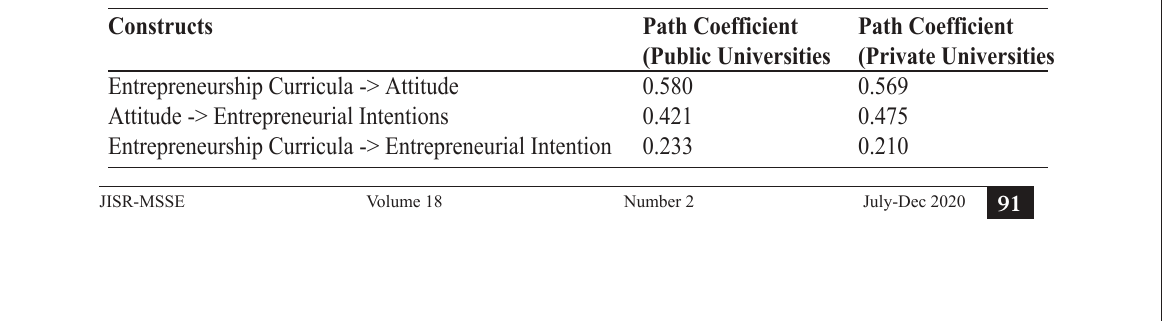
Table 8: Comparison Based on Path